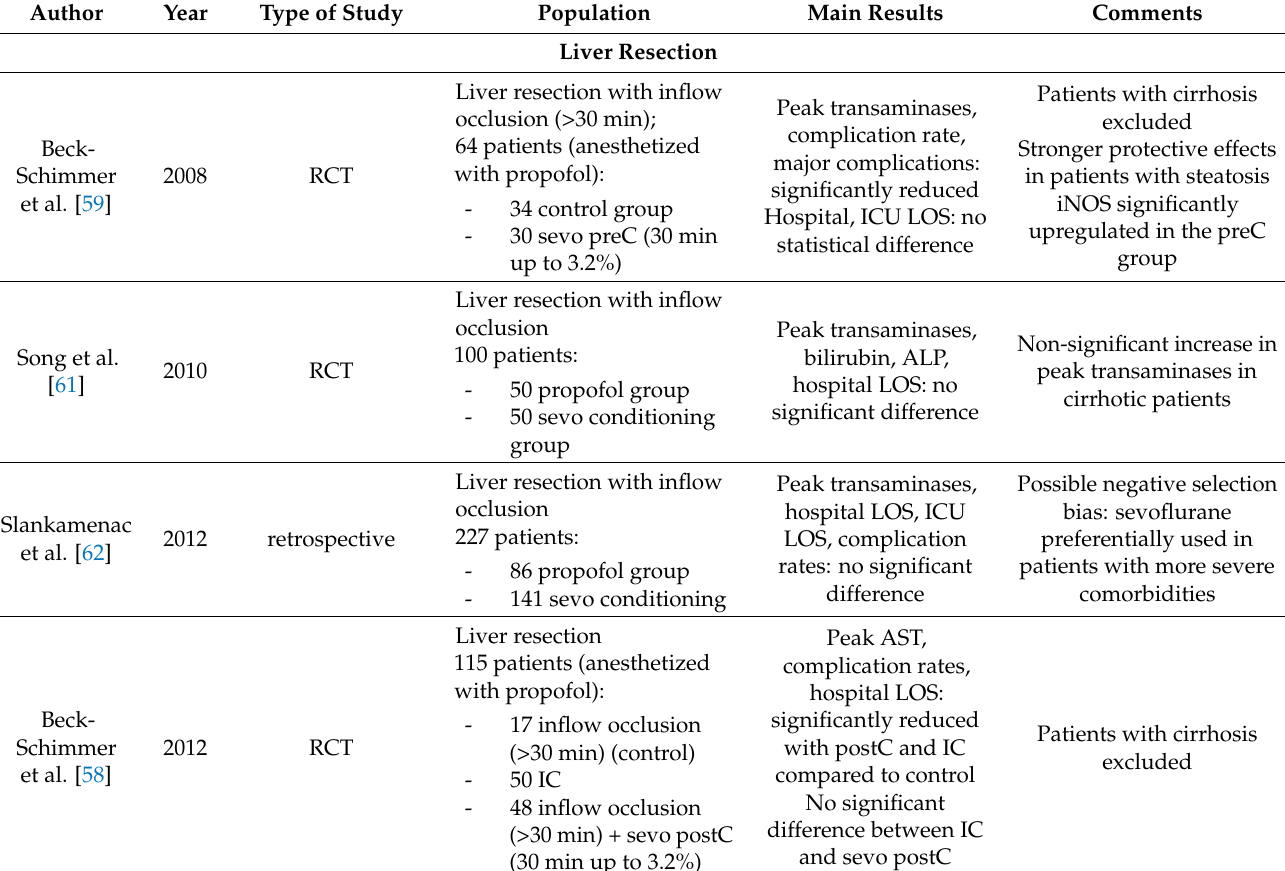
Table 2. Clinical